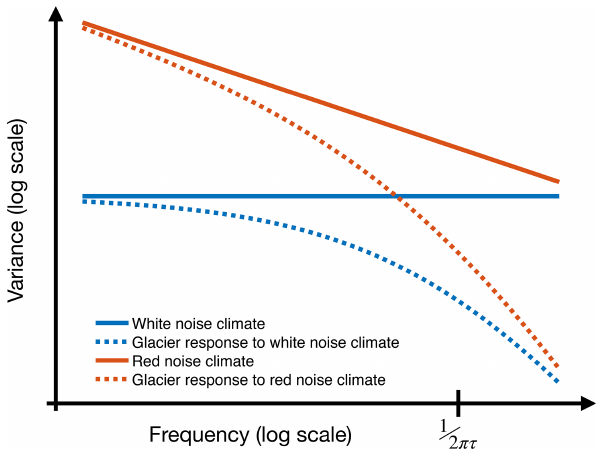
Figure 3. Schematic illustration of time series power spectra, rep- resenting the relative magnitude of variance as a function of fre- quency. A white spectrum is flat (solid blue line), indicating uniform variance at all frequencies. A red spectrum has a negative slope (solid red line), indicating greater variance at low frequencies. A glacier acts as a low-pass filter, resulting in a redder spectrum for glacier length than for annual mass balance, which varies with tem- perature and precipitation. The variance in annual mass balance that is retained in time series of glacier length drops sharply beyond the cut-off frequency of ( 2 πτ) − 1